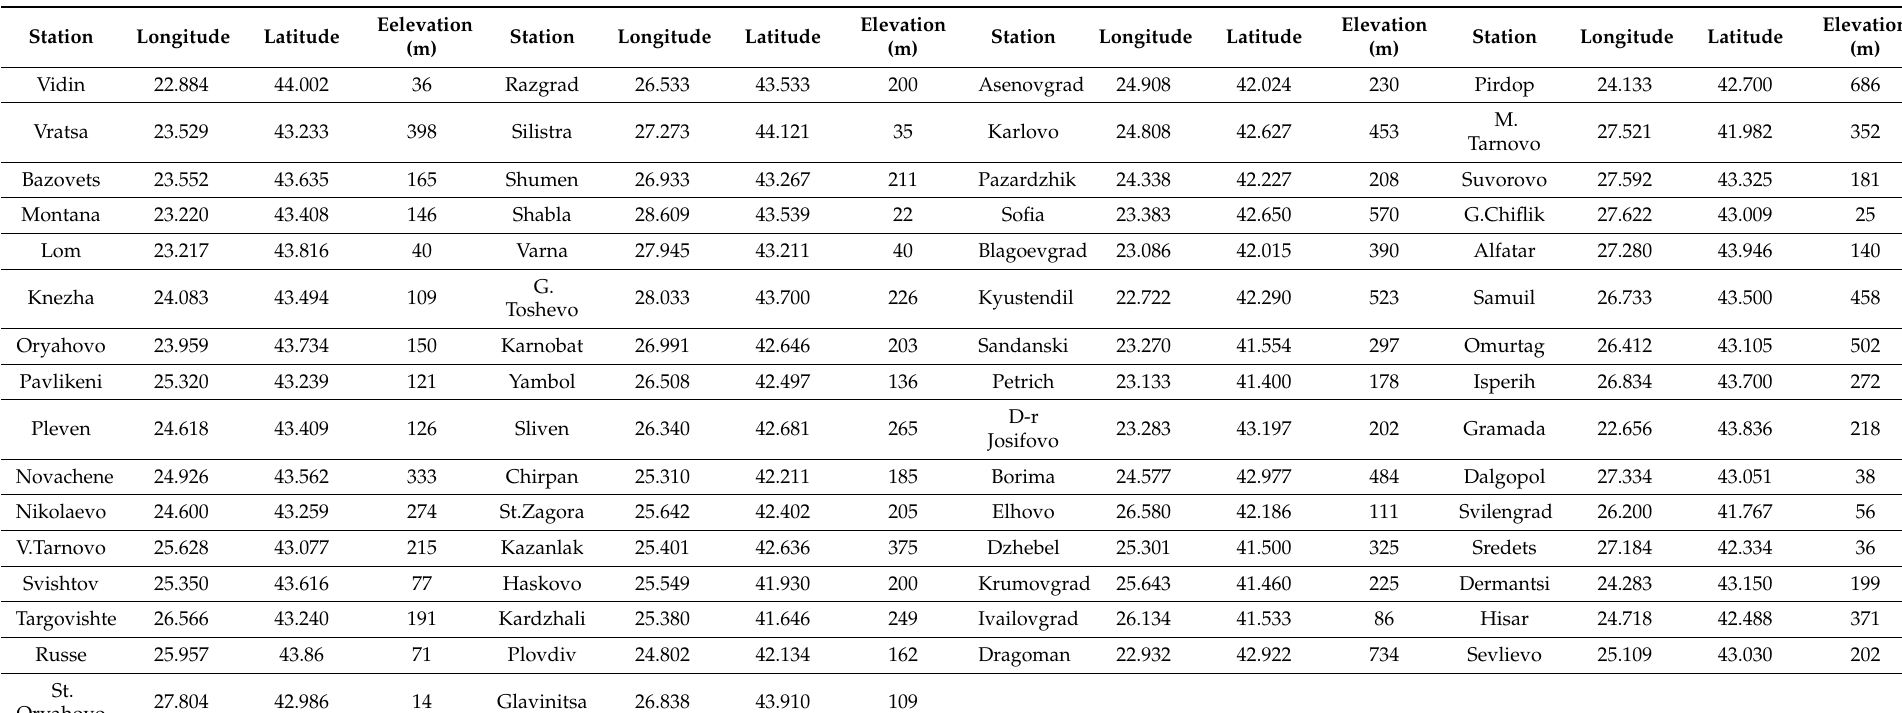
Table 1. Geographic coordinates—latitude, longitude, and elevation of 65 meteorological and agrometeor-ological stations subject of this study.